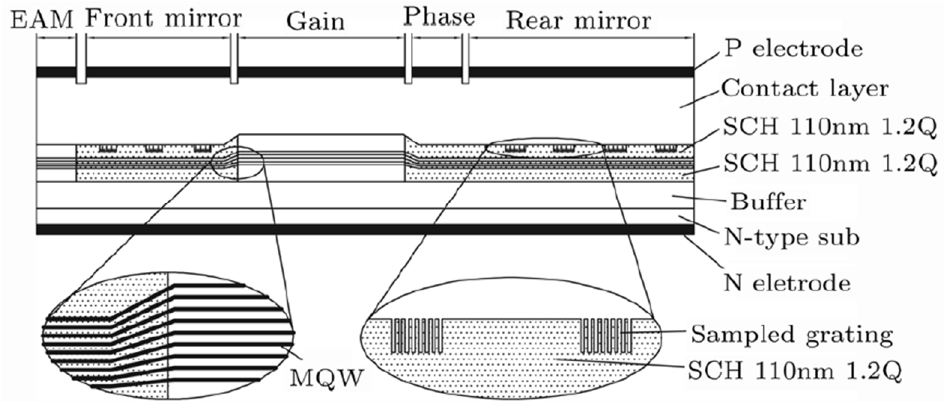
Figure 23. Schematic of EML consisting of a SG-DBR laser and EAM by combining SAE and QWI. The active region consisted of eight compressively strained InGaAsP MQWs. The 1.2 Q InGaAsP was used as the SCH structure. The grating mask and contact layer were InP layers. Reprinted with permission from ref. [84] © Chinese Physical Society. Copyright 2008 Chinese Physics Letters.